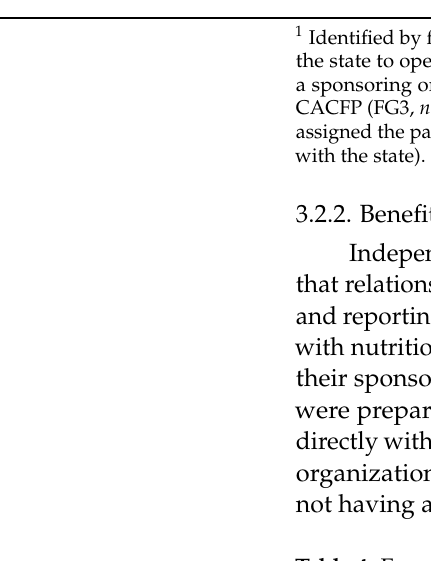
Table 4. Emergent themes of benefits of working with a CACFP sponsoring organization 1.